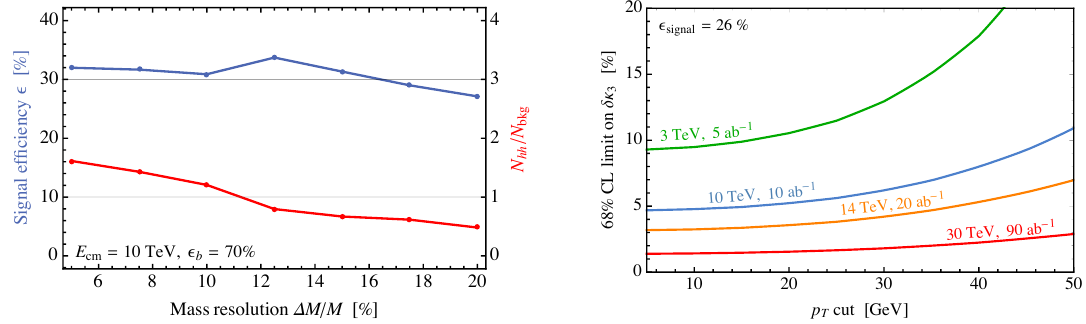
Figure 9 . Left: hh signal efficiency and ratio of signal over background events, as functions of the di-jet mass resolution, for E cm = 10 TeV , and (cid:15) b = 70% . Right: 68% C.L. limit on δκ 3 as a function of the acceptance cut on the jet transverse momentum, for different VHEL energies.